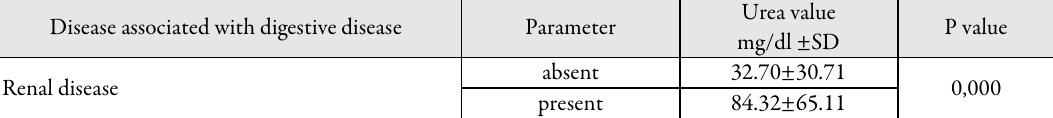
Table 4. Average values of blood urea in the target group for kidney disease in comorbidity, at discharge Disease associated with digestive disease